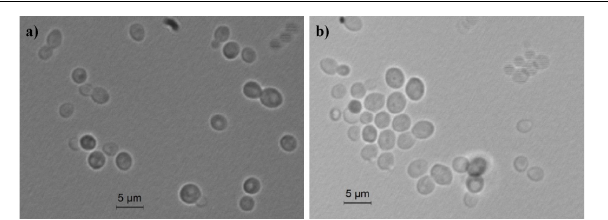
FIGURE 1 | Light microscopic morphology of cells of O. uvarum CBS 12829. Panel (a) O. uvarum cells in YM broth; Panel (b) O. uvarum cells in YEPD